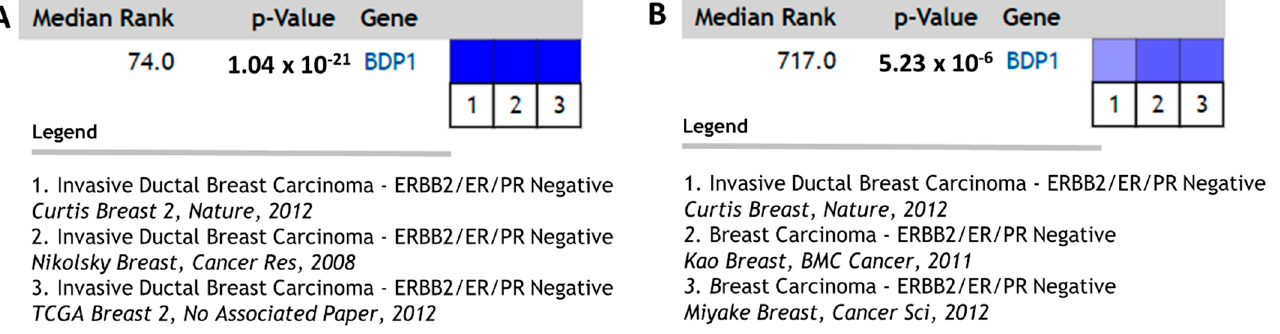
Figure 5. BDP1 is altered in triple-negative breast cancer. ( A ) BDP1 copy number decreased in triple-negative breast cancer, p = 1.04 × 10 − 21 (gene rank 74), n = 3785 samples [40,44,47]. ( B ) BDP1 expression is decreased in triple-negative breast cancer, p = 5.23 × 10 − 6 (gene rank 717), n = 2434 samples [40,42,43]. The Oncomine™ Platform (Thermo Fisher, Ann Arbor, MI, USA) was used for analysis and visualization.